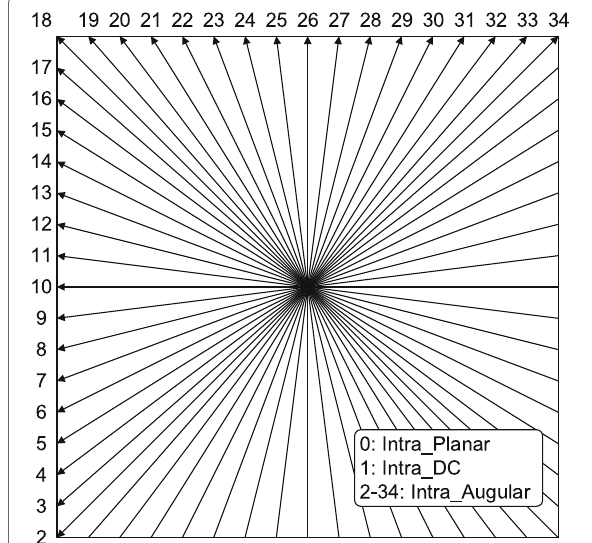
Fig. 1 Quad-tree partitioning structure of a CU